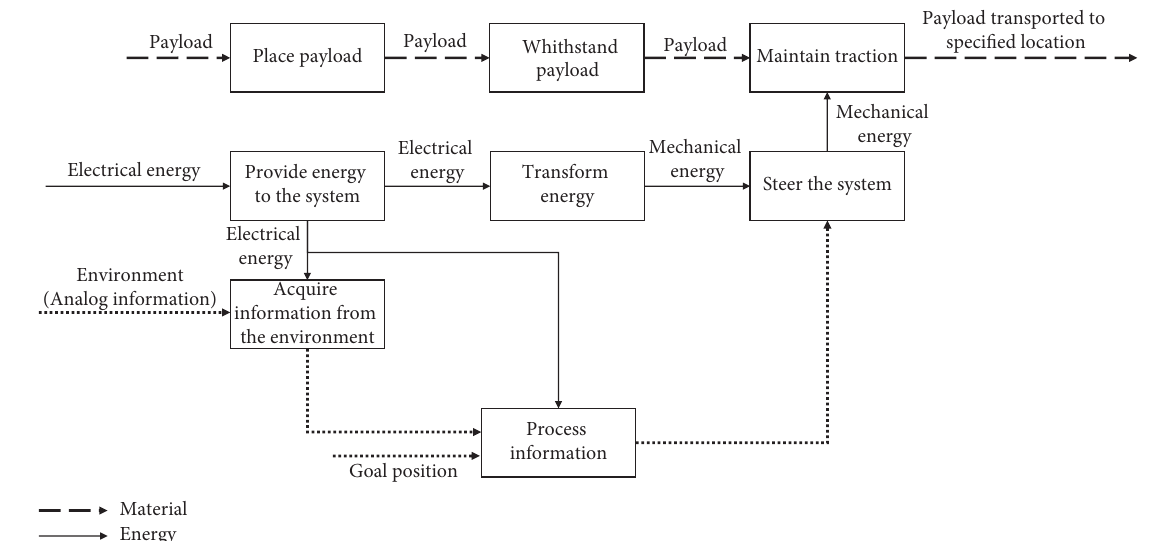
Figure 3: Functional representation of the